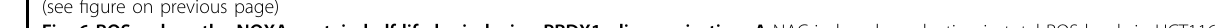
Fig. 6 ROS reduce the NOXA protein half-life by inducing PRDX1 oligomerization. A NAC induced a reduction in total ROS levels in HCT116 cells: HCT116 cells in a 6-well plate were treated with 5 mM NAC for 0 – 4 h and were then analyzed by fl ow cytometry to measure the total intracellular ROS level. The mean ± SD values of three experiments were plotted using Prism 8 software. B Under NAC treatment, the protein level of NOXA apparently increased, while the total protein level of PRDX1 was unaffected: HCT116 cells in 6-well plates were treated with 5 mM NAC for 0 – 4 h and were then lysed with RIPA before WB analysis. C NAC treatment reduced NOXA transcription: mRNA levels of NOXA with respect to those of β -actin in HCT116 cells after treatment with 5 mM NAC for 0 – 4 h. n = 12, mean ± SD, plotted using Prism 8 software. D Analysis of the in fl uence of NAC on the degradation rate of NOXA: HCT116 cells in 6-well plates were pretreated with NAC (5 mM) for 1 h prior to CHX treatment for a fi xed duration before being lysed for WB analysis. The results are representative of three independent experiments, and band densities were quanti fi ed using Image Lab software and plotted using Prism 8 software (mean± SD). E Analysis of the in fl uence of NAC on CUL5 neddylation: HCT116 cells in 6-well plates were pretreated with NAC (5 mM) for 0 – 4 h before being lysed for WB analysis. F A working model: PRDX1 protects CRC cells from NOXA-dependent apoptosis by promoting NOXA degradation through enhancing CUL5